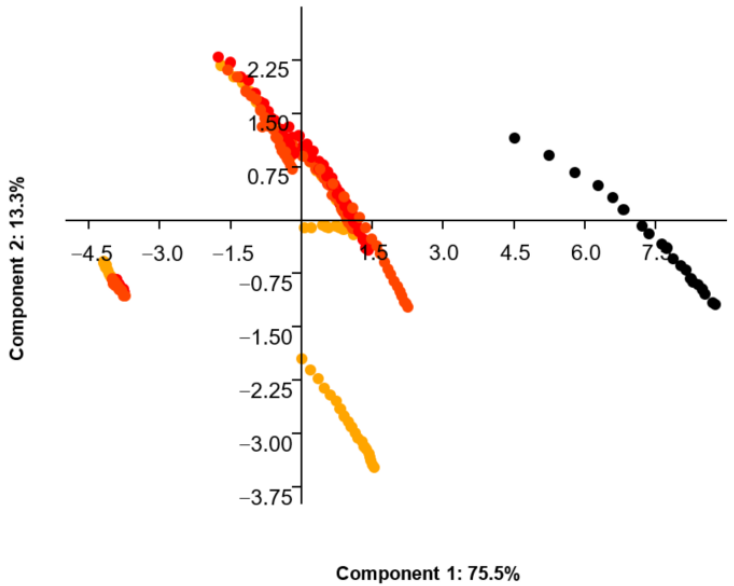
Figure 8. Biplot of PCA based on electronic-nose data clustered by toasting. Black dots, Control sample; red dots, heavy toasting; orange-red dots, light toasting; orange dots, not toasted.